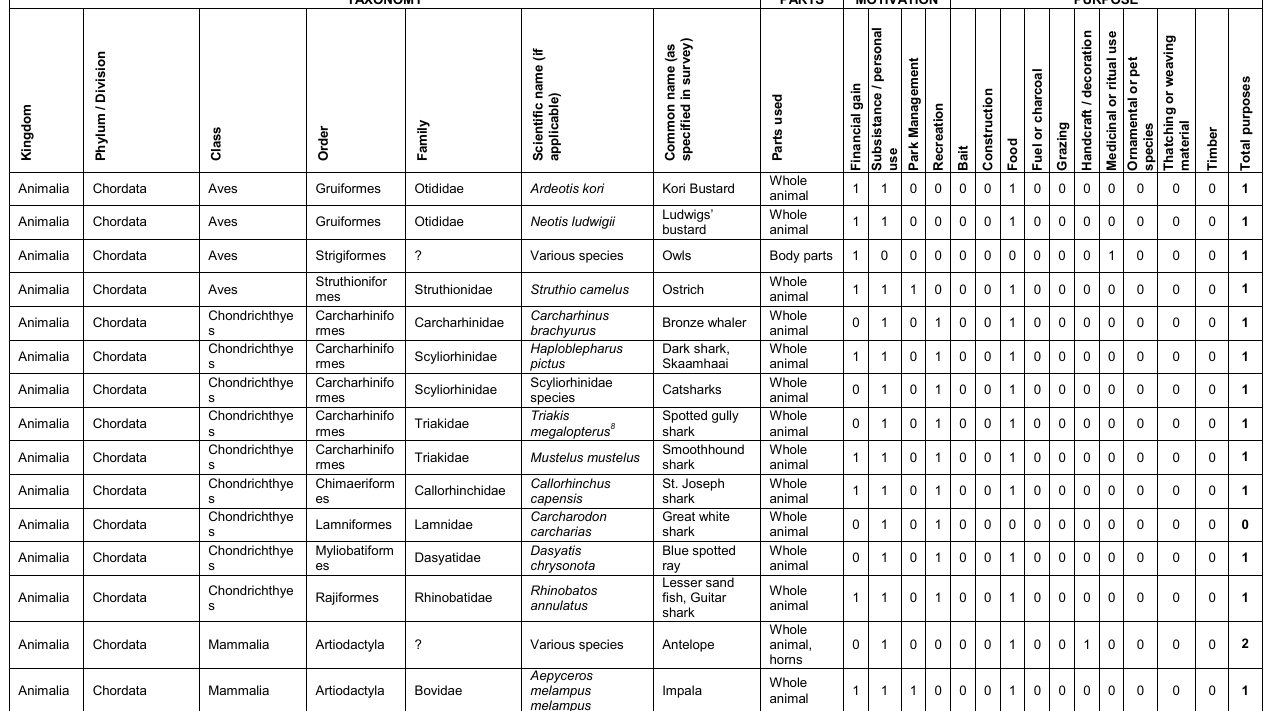
Animalia Chordata Mammalia Artiodactyla ? Various species Antelope Animalia Chordata Mammalia Artiodactyla Bovidae